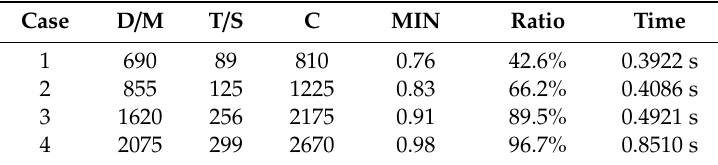
Table 2. The parameters of the experiments.